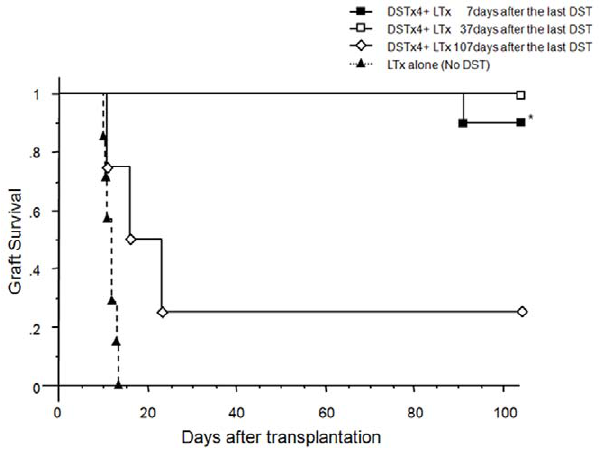
Figure 1. Donor specific blood transfusion (DST) induces tolerance to liver allografts. LEW rats were pretreated with 1 ml of heparinized DA blood (DST) once per week for 4 weeks prior to DA liver transplantation (LTx). LTx was performed 7 days following last DST treatment (DSTx4 + LTx 7days; black squares, n=10). DSTx4 + LTx 37days (white squares, n=5) and DSTx4 + LTx 107days (white diamonds, n=4) represent LEW rats pretreated once per week for 4 weeks with DST with LTx performed at 37 or 107 days following last DST treatment. Some animals did not receive DST but did receive LTx (black triangles, n=7). *P , 0.05 compared with LTx alone.